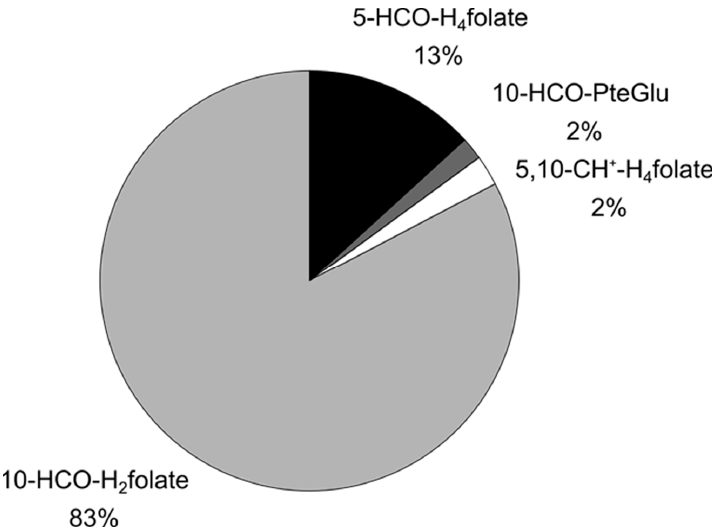
Figure 3. Chronological composition of a 5-HCO-H 4 folate solution during the simulated digestion.